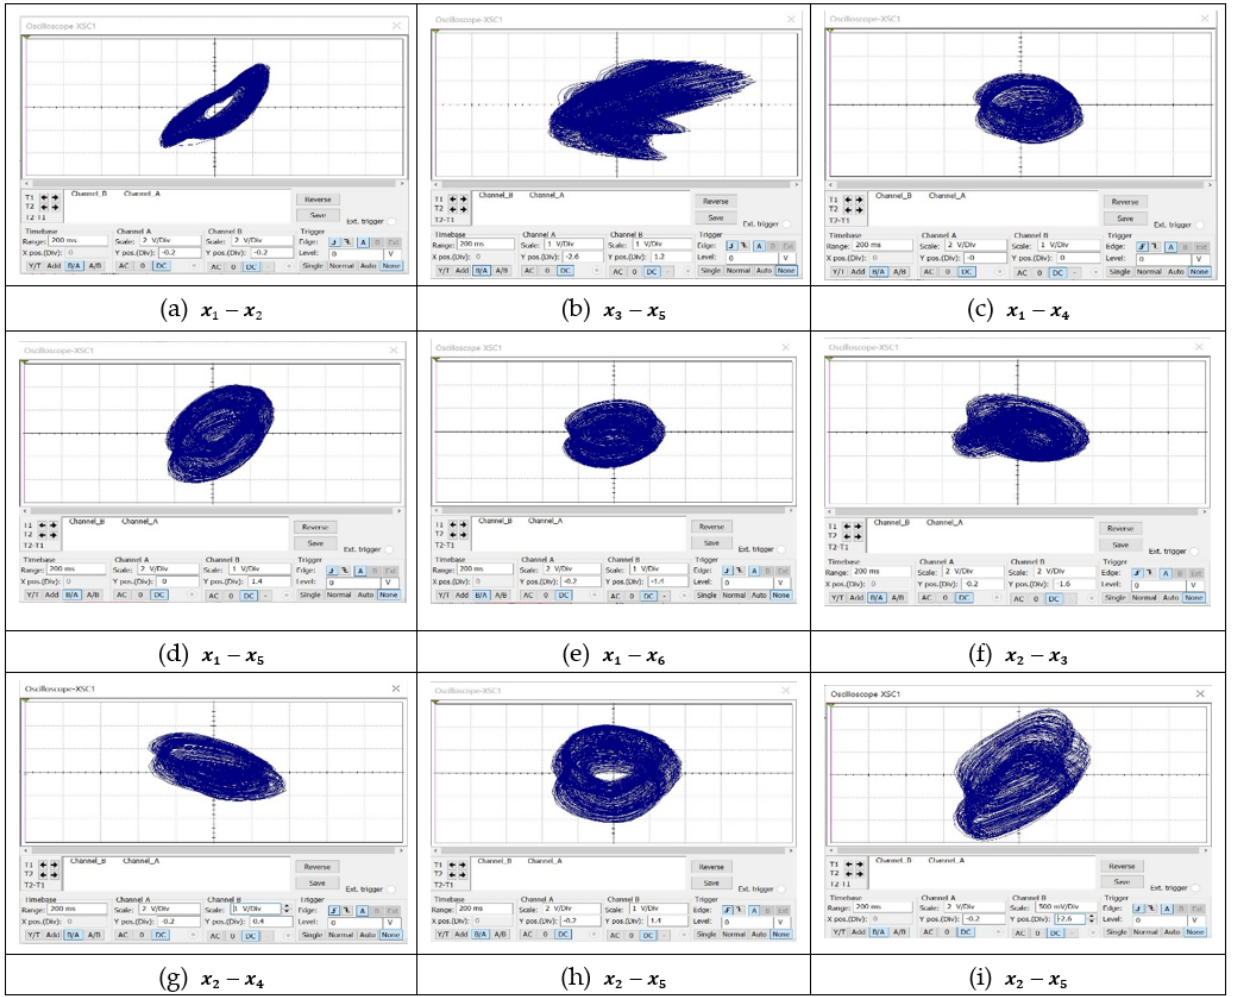
Figure 5. MultiSIM hyperchaotic attractors of the new chaotic system (43) : ( a ) x 1 − x 2 ; ( b ) x 3 − x 5 ; ( c